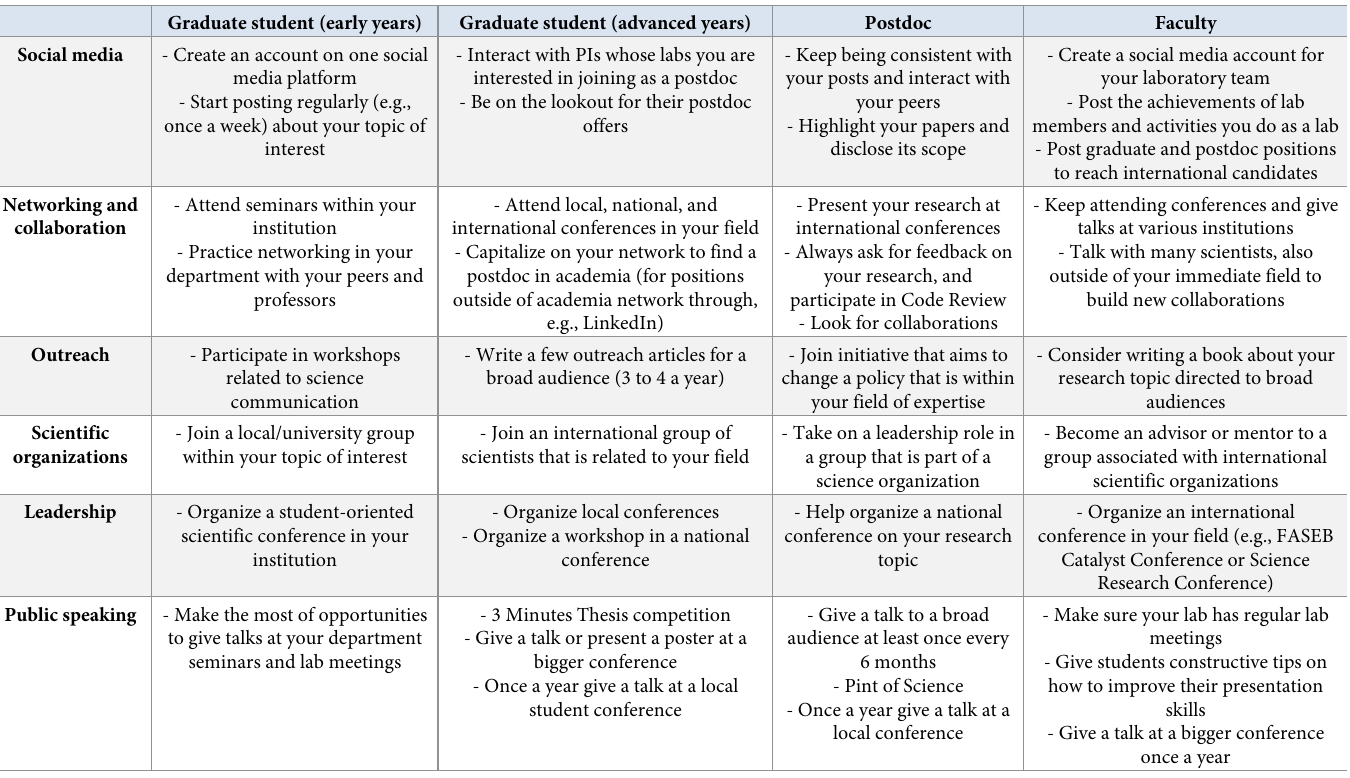
Table 2. Activities according to the stage of the scientific